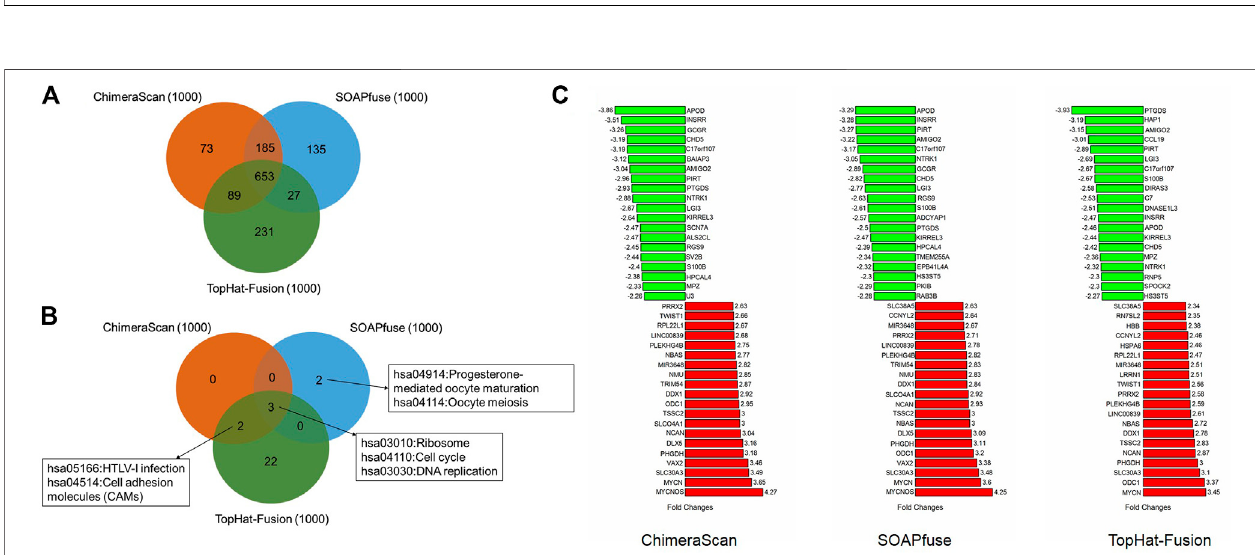
FIGURE5| Thecomparativeanalysisofthedifferentialexpressedgenes(DEGs)andrelatedKEGGpathwaysregulatedbytherede fi nedhigh-riskgroup: (A) aVenn diagram of DEGs regulated bythe rede fi ned high-risk group for the three fusion detection algorithms; (B) a Venn diagram ofKEGG pathways enriched by DEGs; (C) the top 20 up- and down-regulated genes of DEGs derived from the three algorithms.